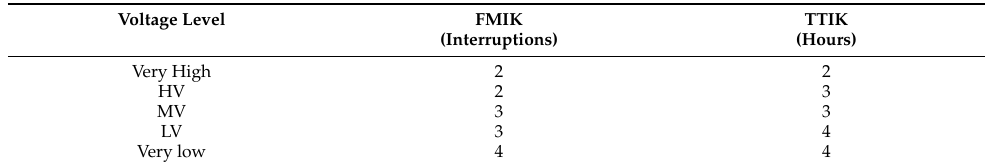
Table 14. Tolerance limits for indicators in Venezuela per installed kVA.